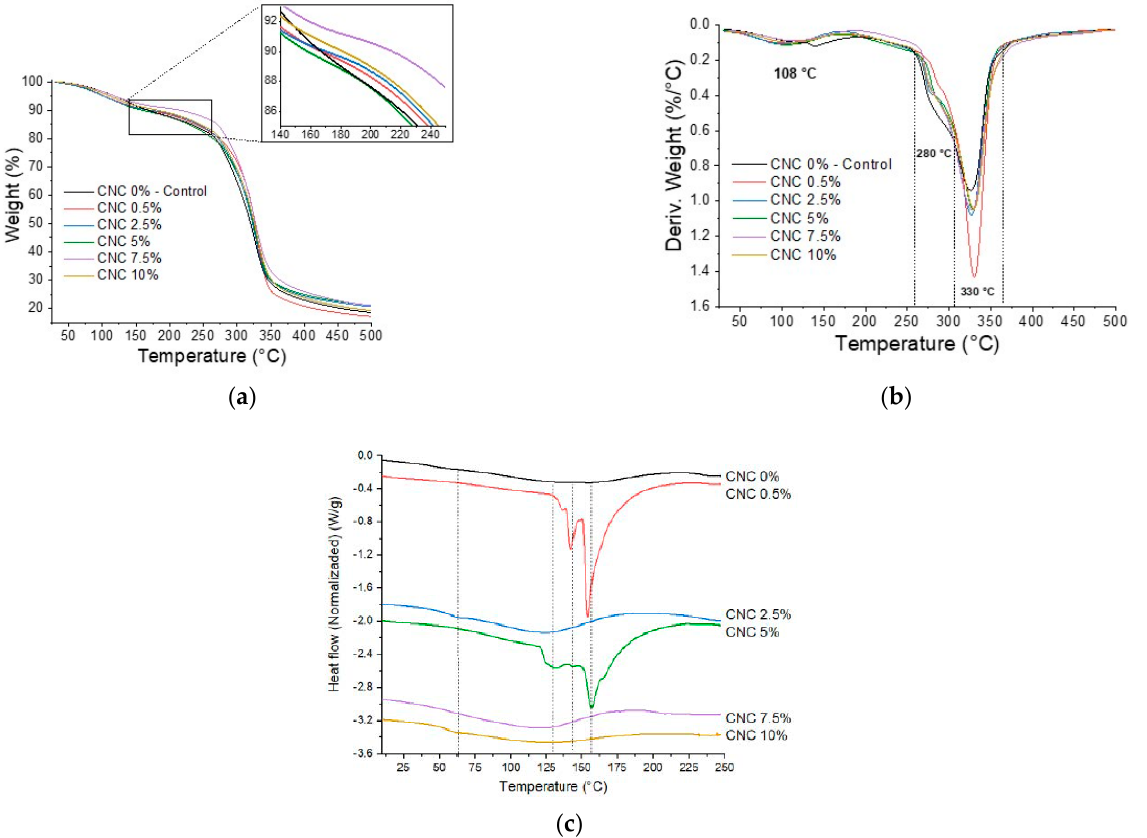
Figure 3. ( a ) TGA, ( b ) DTG curves, ( c ) DSC thermogram of biopolymer (corn starch–chitosan) and nanocomposite films incorporated with different concentrations of CNC (0 to 10% w / w ).